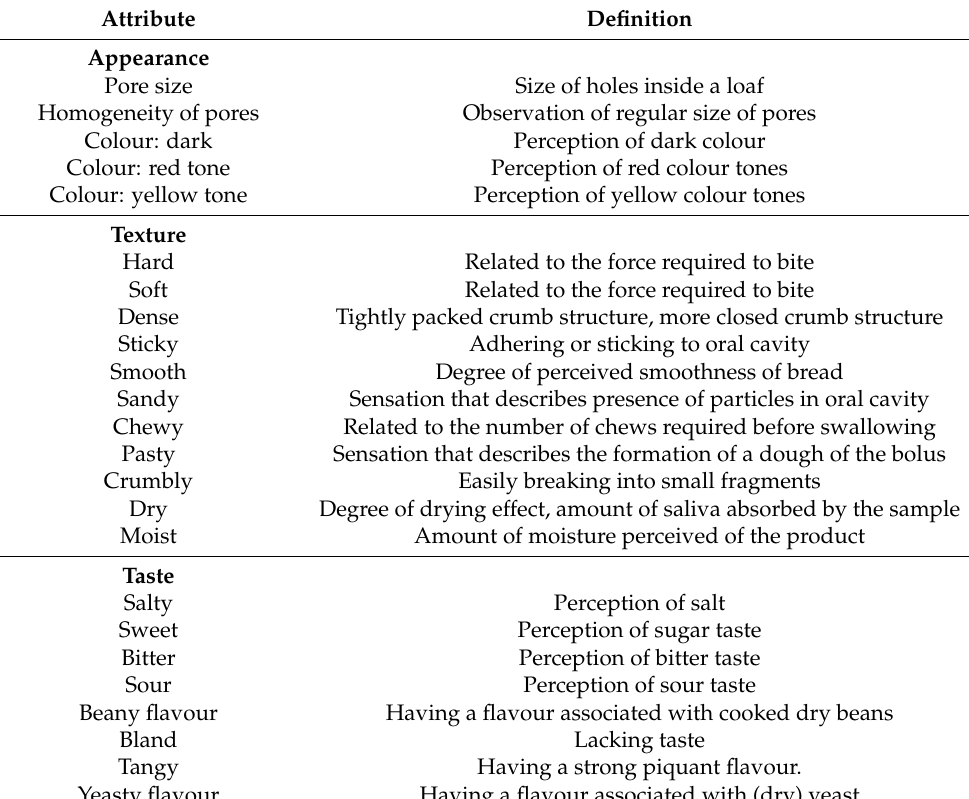
Table 2. List of descriptors and definitions used in the RATA test with naive